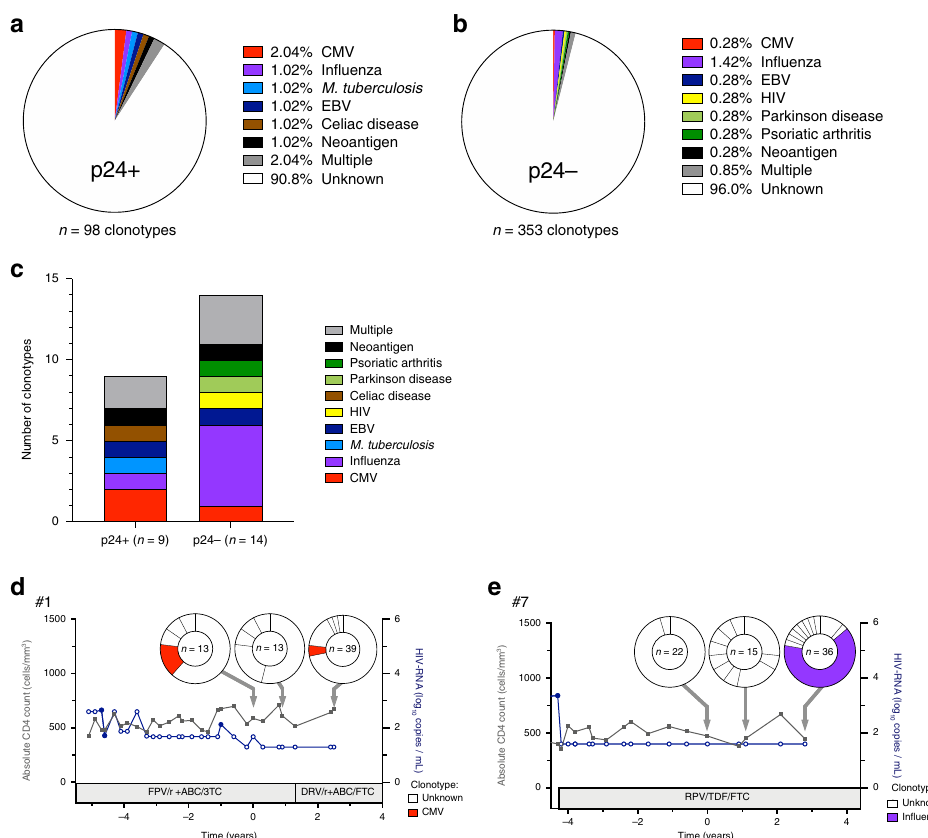
Fig. 5 Predicted antigen speci fi city of p24 + cells. a , b Pie charts depicting the proportion of clonotypes with predicted antigen speci fi city in p24 + ( a ) and p24 − ( b ) cells. c Number of p24 + ( n = 9) and p24 − ( n = 14) clonotypes for which the antigen speci fi city could be identi fi ed by TCR similarity analysis. d